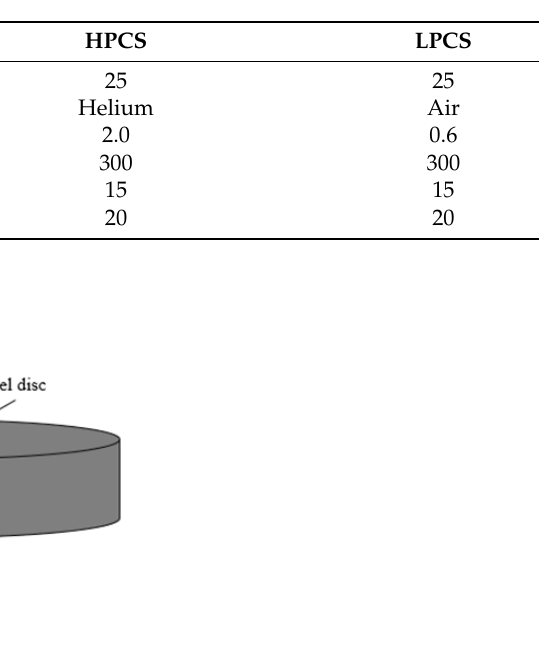
Figure 1. Schematic diagram of ( a ) HPCS and ( b ) LPCS [24]. Table 1. Spraying parameters of HPCS and LPCS.